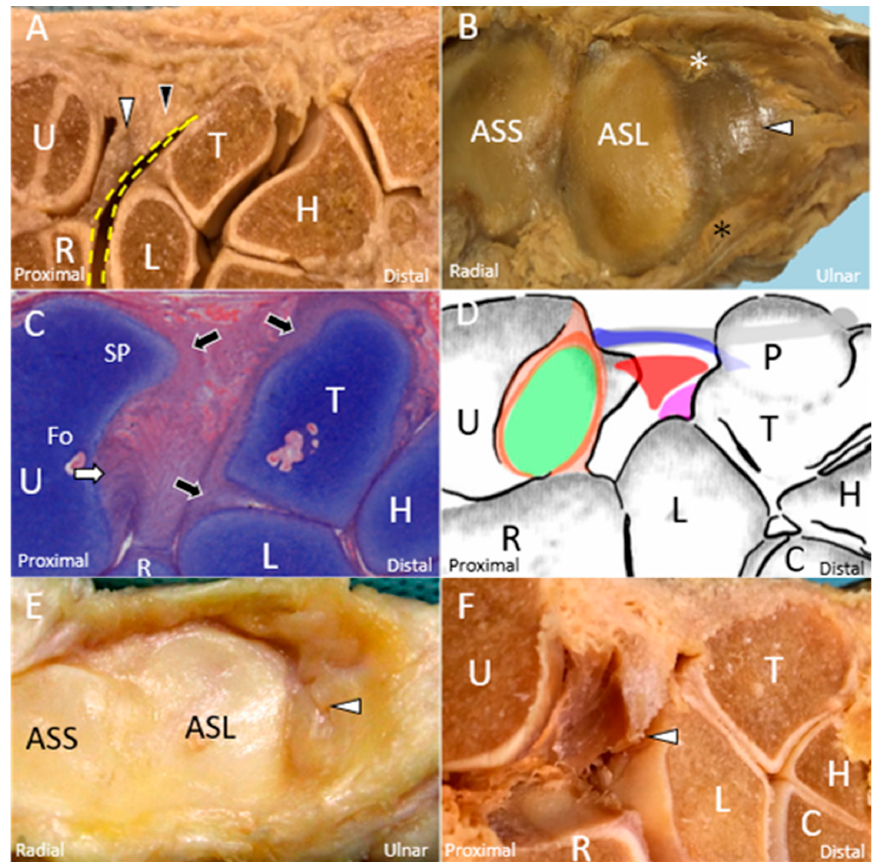
Figure 1. The cadaveric model shows the articular disc (white arrowhead) and meniscus homologue (black arrowhead) . ( A ) Between the disc and the carpal bones is the prestyloid recess (yellow dashed line) . ( B ) The disc (white arrowhead) is surrounded by the dorsal (white asterisk) and palmar (black asterisk) radioulnar ligaments. ( C ) The deep limb of the radioulnar ligament (white arrow) is inserted into